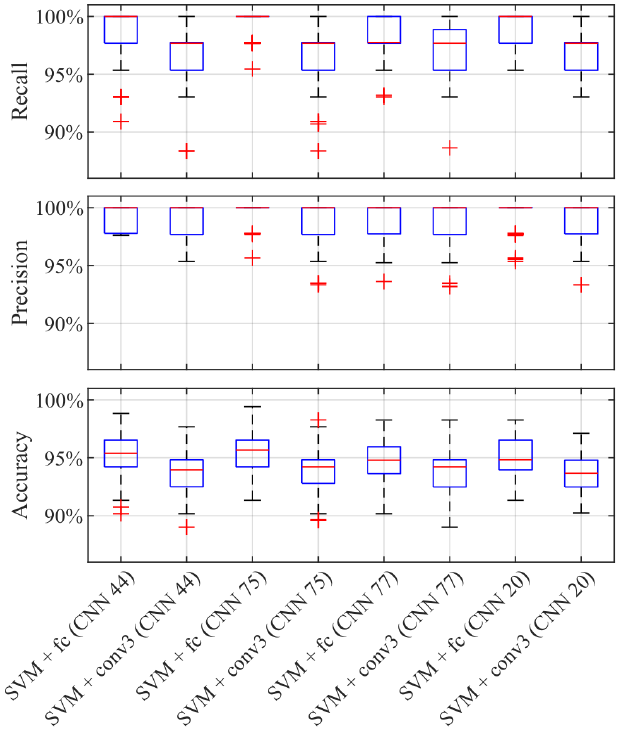
Figure 13. 10-by-10 cross-validation results of SVMs trained on features extracted from the fully connected layer and the third convolutional layer of our selected trained simple